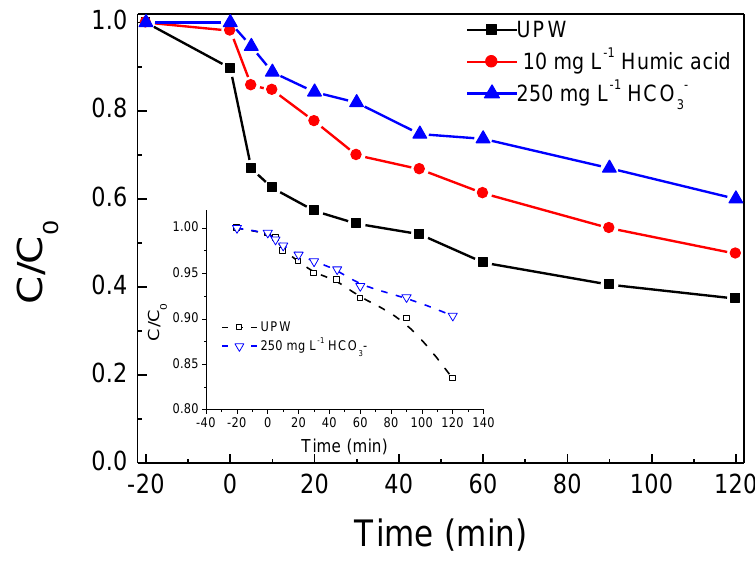
Figure 9. Effect of the addition of bicarbonate or humic acid on 500 µ g L − 1 SMX degradation with 500 mg L − 1 RHB700 and 500 mg L SPS at inherent pH. Inset graph shows adsorption of SMX in the presence and absence of bicarbonate. Table 1. The k app values for SMX degradation and the amount of SMX adsorbed at 20 min in µ g of SMX/mg biochar for RHB700 and RHB850 in the presence of different scavengers. The values for UPW are also presented. RHB700 RHB850 Scavenger k app (min − 1